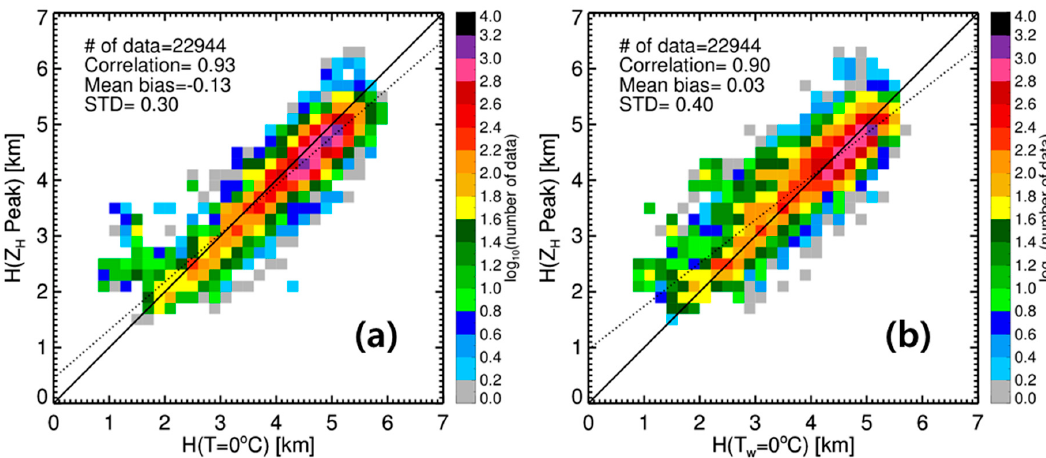
Figure 9. Two-dimensional frequency distributions between ( a ) H(Z H Top) and H(T = 0 °C) and between ( b ) H(Z H Top) and H(T w = 0 °C).